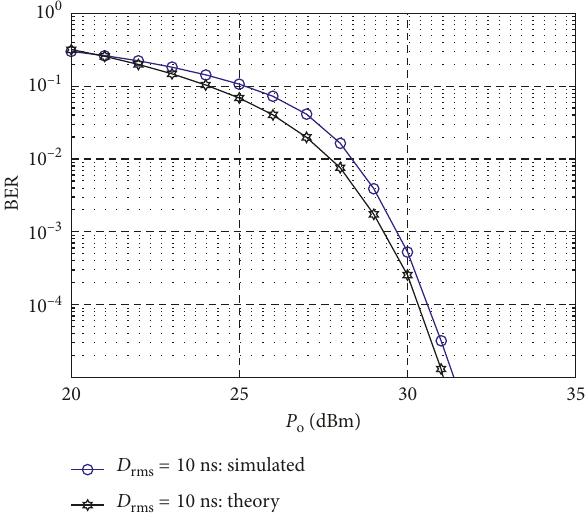
Figure 11: Theoretical and simulated BER of STACO-OFDM in terms of transmitted optical power for a system with spectral ef- ficiency of 1.5bits/s/Hz over multipath channel with D rms of 10 ns.